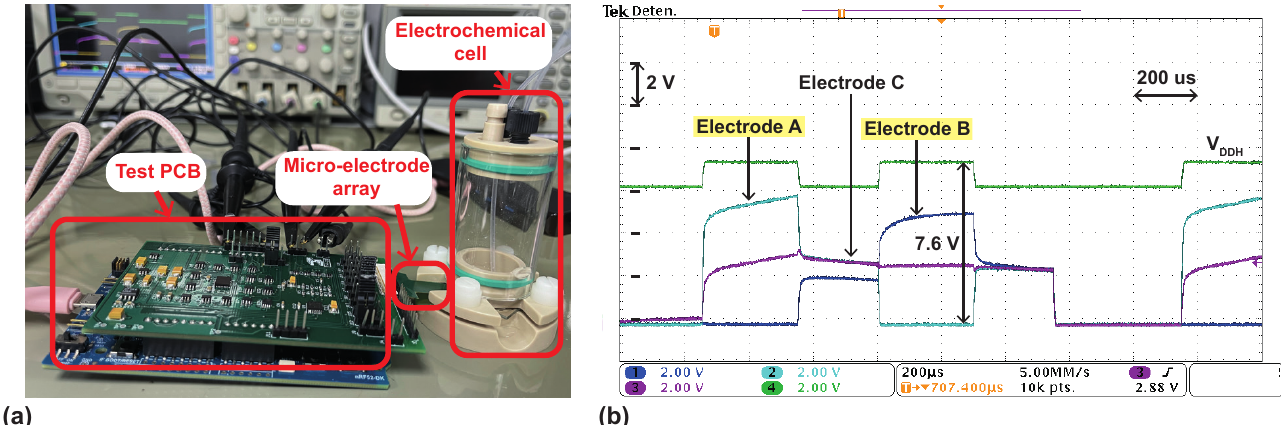
Figure 15. ( a ) Photography of the test-bench for stimulation in a PBS solution. ( b ) Electrodes’ voltages when a 2mA stimulation current is delivered to a PBS